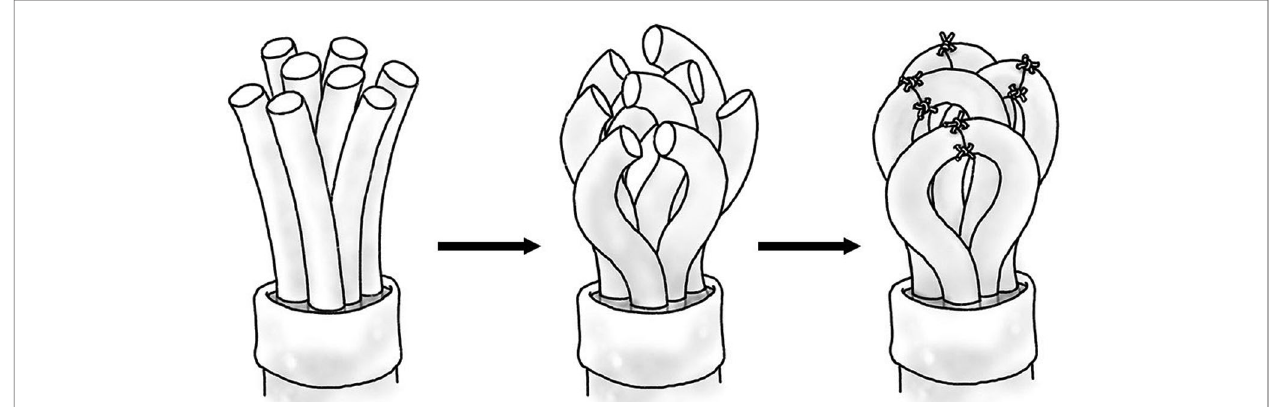
FIGURE 4 | Diagram of fascicular end-to-end